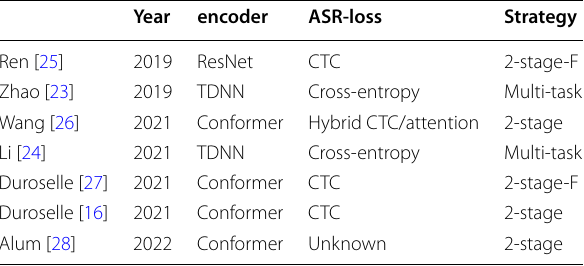
Table 1 Previous proposed